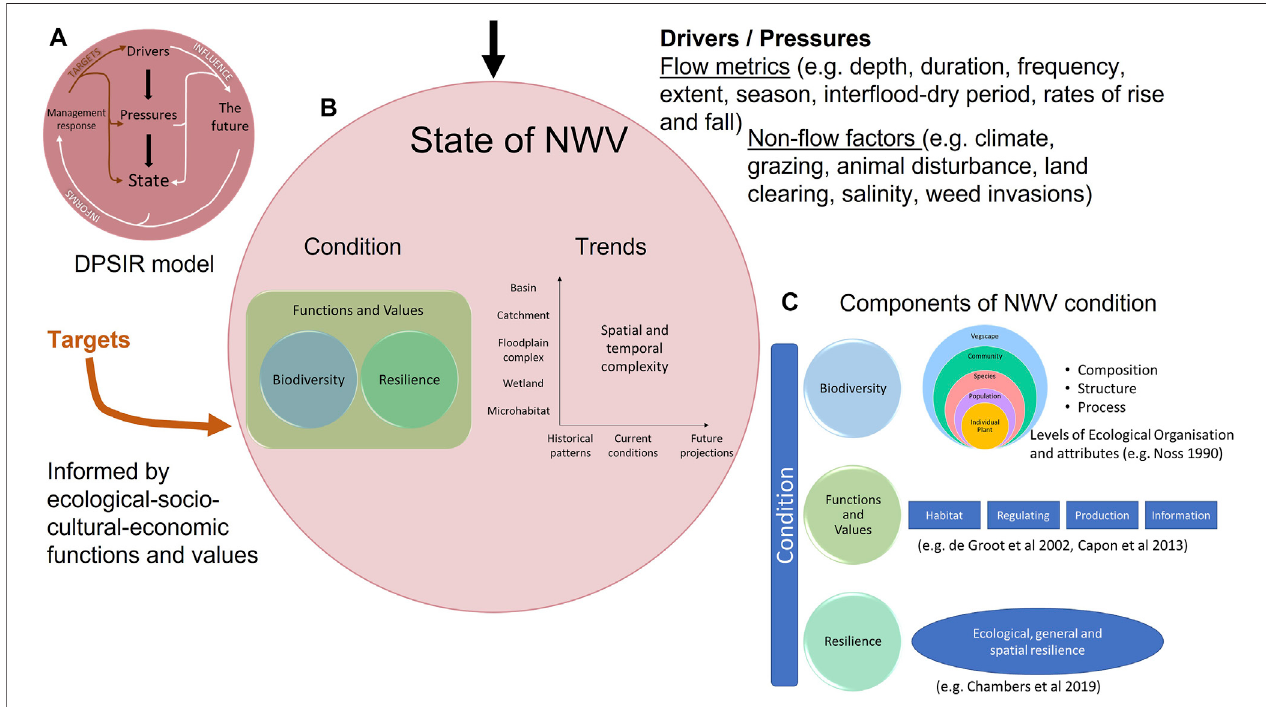
FIGURE 1 | Conceptual framework depicting key components in the characterisation of non-woody vegetation (NWV) condition in fl oodplain-wetland environments: (A) represents the common use of “ state ” in Driver-Pressure-State-Impact-Response models and the links with targets and drivers and pressures [redrawn from (Jackson 2017)]; (B) depicts thestateofNWV ascondition and trends, where condition incorporates functionsand values, biodiversityand resilience and trends covers both spatial and temporal complexity; (C) represents the components of NWV condition within biodiversity, functions and values and